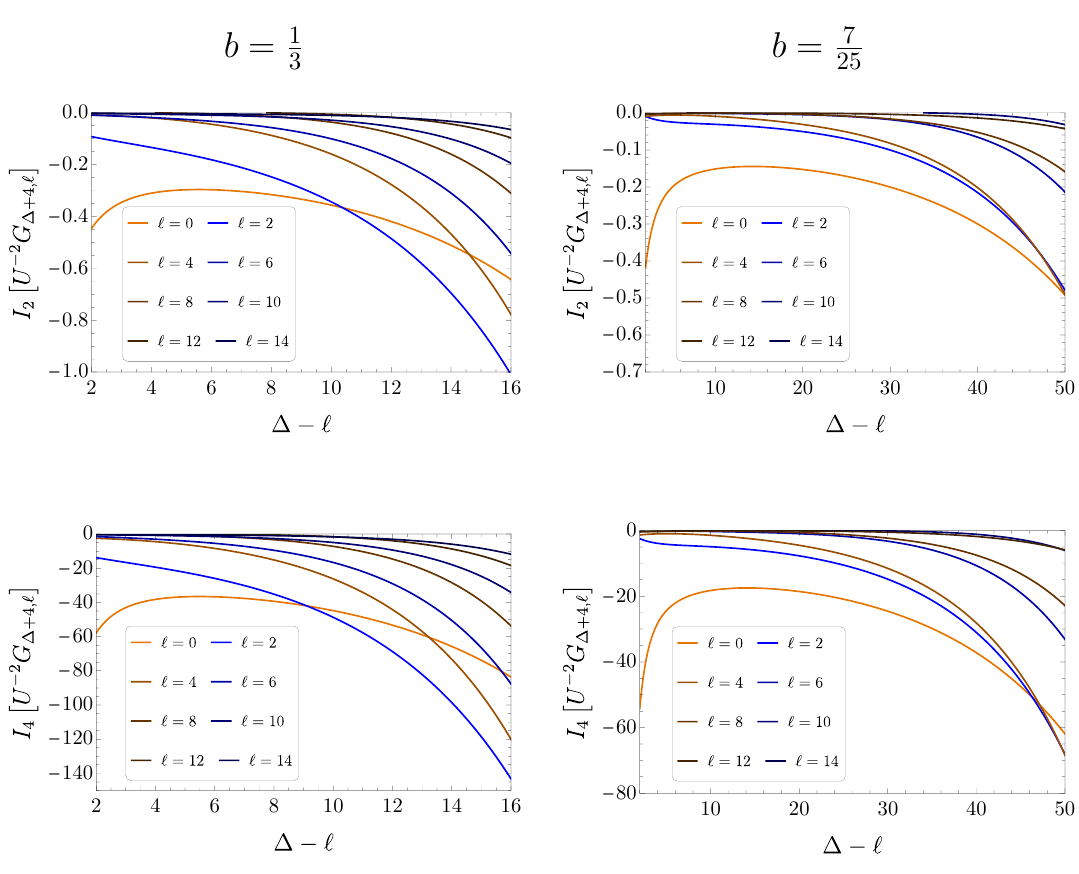
Figure 6 . Integrated constraints I 2 and I 4 (2.15) acting on blocks U − 2 G ∆+4 ,‘ as they appear in the block expansion (2.9) for spins ‘ = 0 , 2 , . . . , 14 . For each spin, we begin plotting at the unitarity bound ∆ = ‘ + 2 . The blocks are computed with r max = 20 in the small r expansion of the integrand in